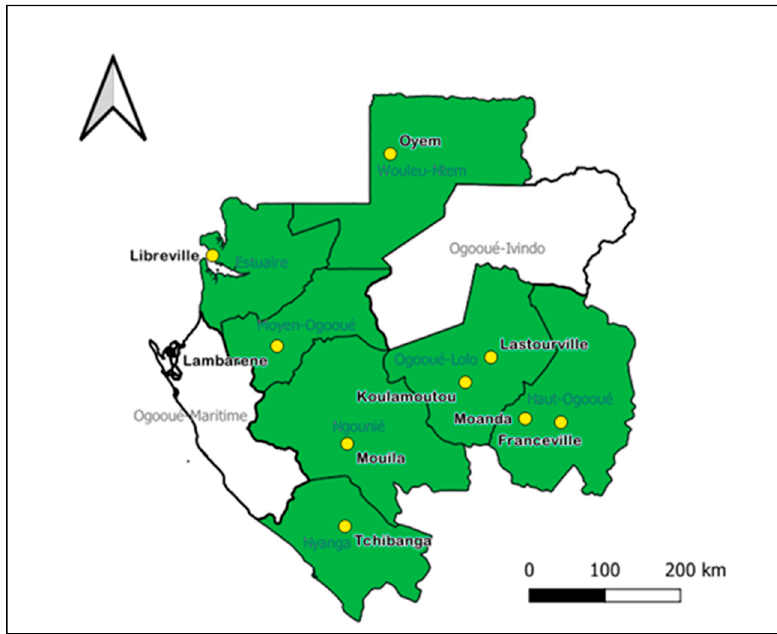
Figure 3. Sampling locations. Green indicates the provinces and yellow represents the cities where the animals were sampled.